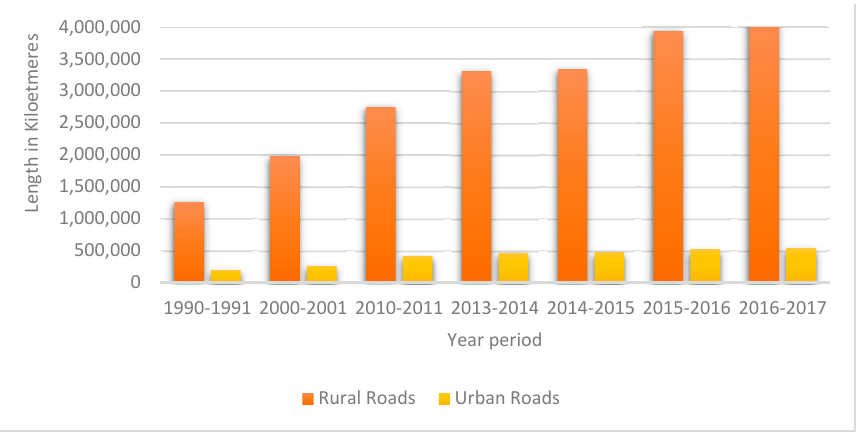
Figure 3. Road construction for rural and urban India in kilometres from 1990 to 2017 [49].